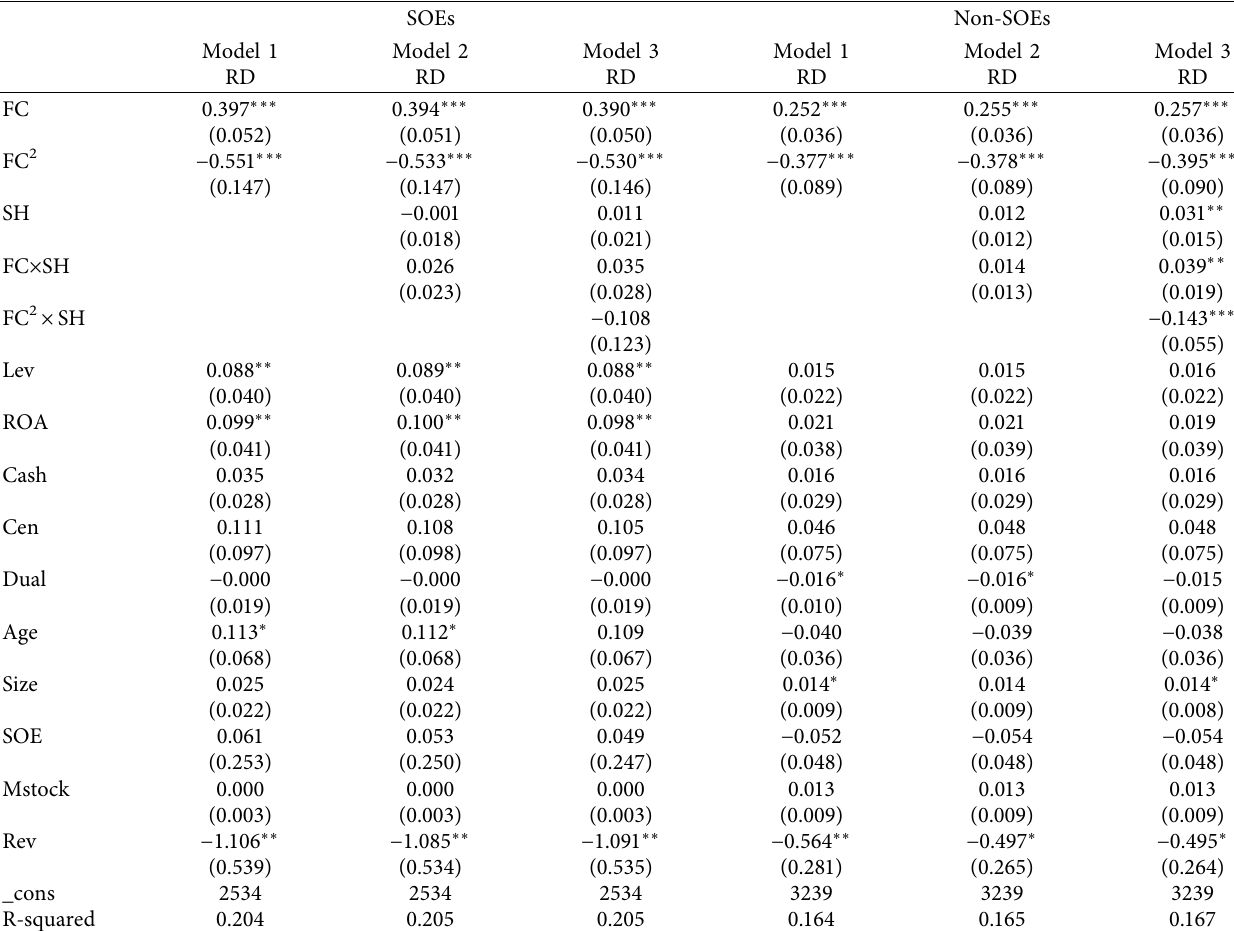
Table 7: Results of subsample analysis on SOEs and